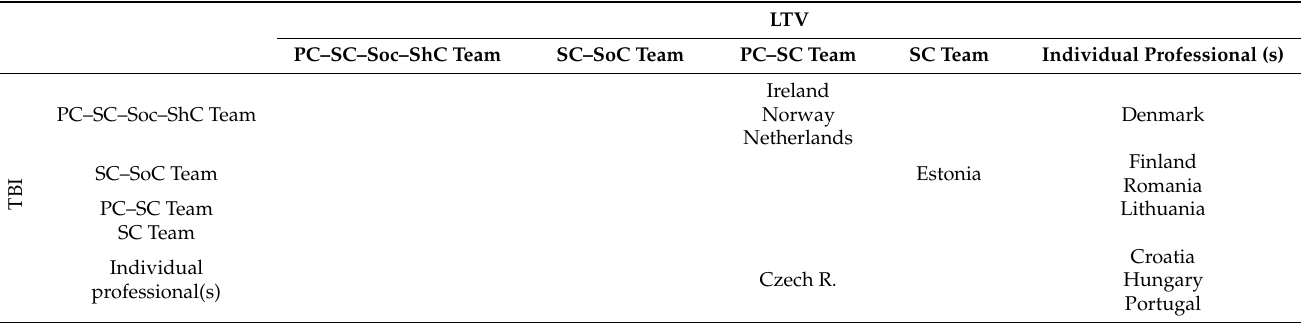
Table 1. Cluster of countries considering the implementation of the personalized written plan for adolescents with TBI and children on LTV.